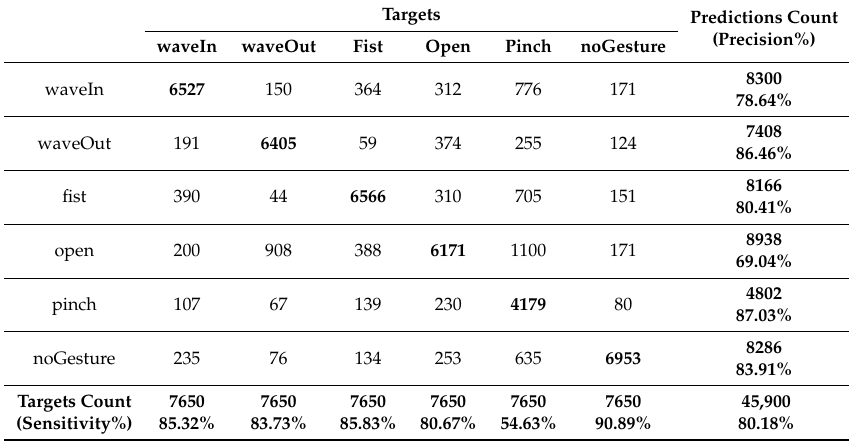
Table A15. Confusion matrix for experiment 3 . Synchronization gestures ( sync = 2 )